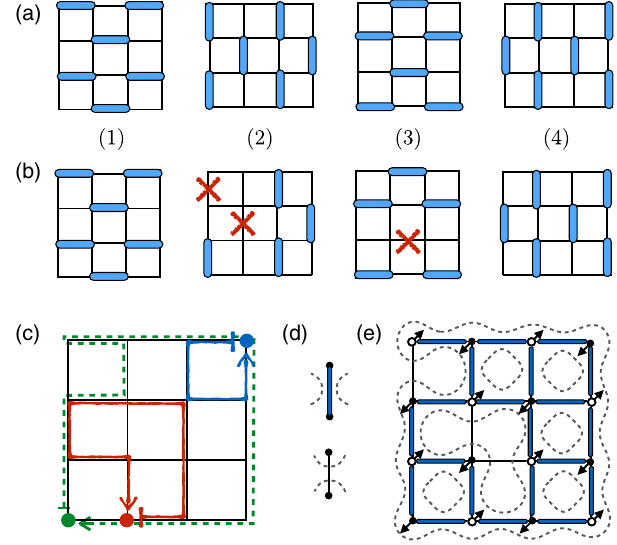
FIG. 10. Percolation picture of diluted SWAP model. (a) A four-step sequence of SWAP gates (blue dimers) that realizes a chiral Floquet model. (b) A disordered SWAP model obtained by turning off bonds at random (red × ’ s). (c) Example micromotion trajectories of three spin flips (red, blue, and green arrows) starting on particular sites (large dots). (d) Rules for drawing the dual loops for an occupied (top) and unoccupied (bottom) bonds in the percolation model. (e) The dual dense-packed loop (dashed lines) representation of a classical percolation cluster, where only the fat blue bonds are occupied. Spin flips in the corresponding diluted SWAP model follow the loop trajectories indicated by the small